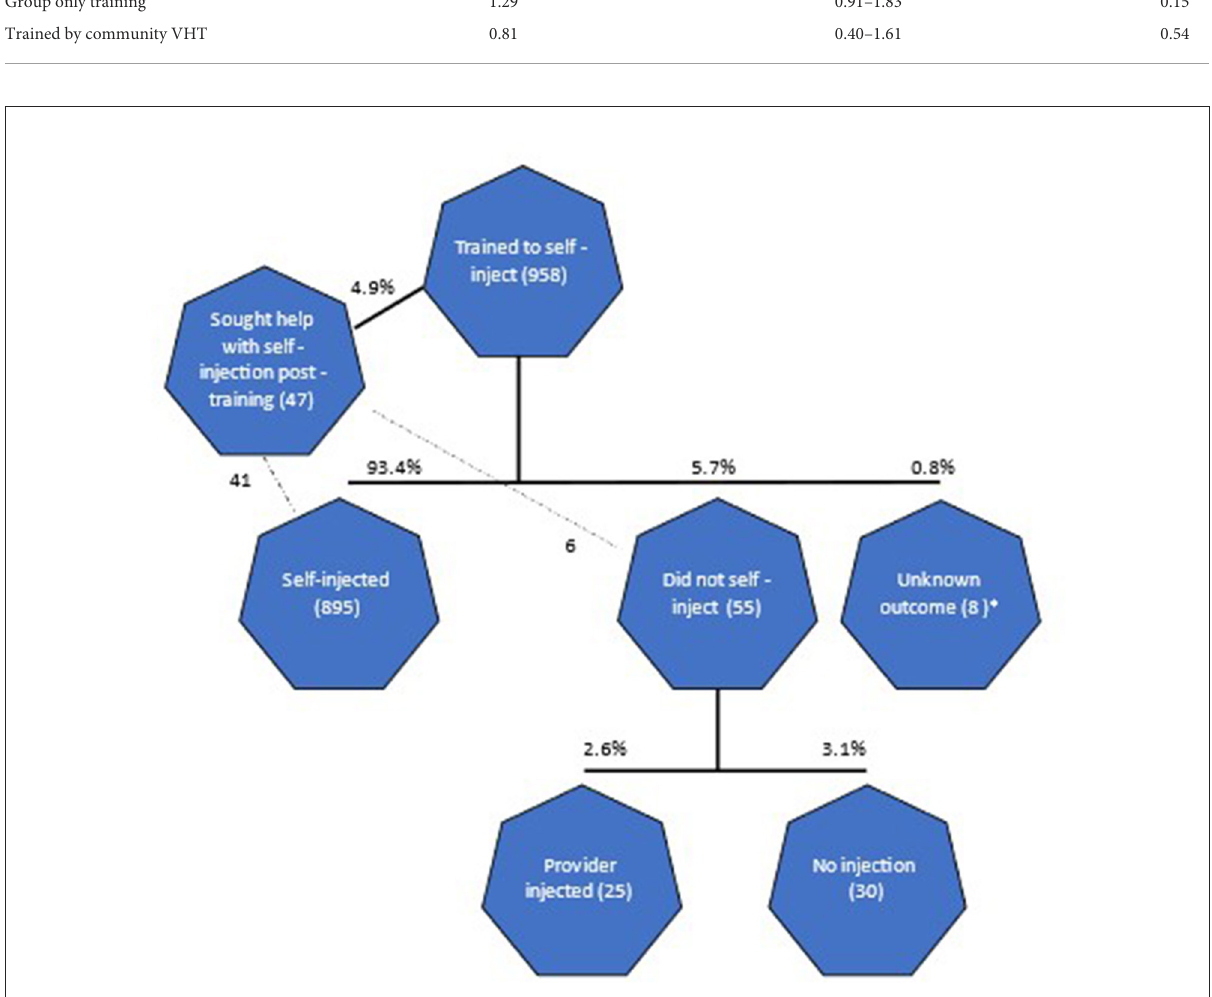
FIGURE1 Flow diagram from training through subsequent contraceptive outcome. *8 individuals have conflicting information as they reported having self-injected yet also indicated zero times